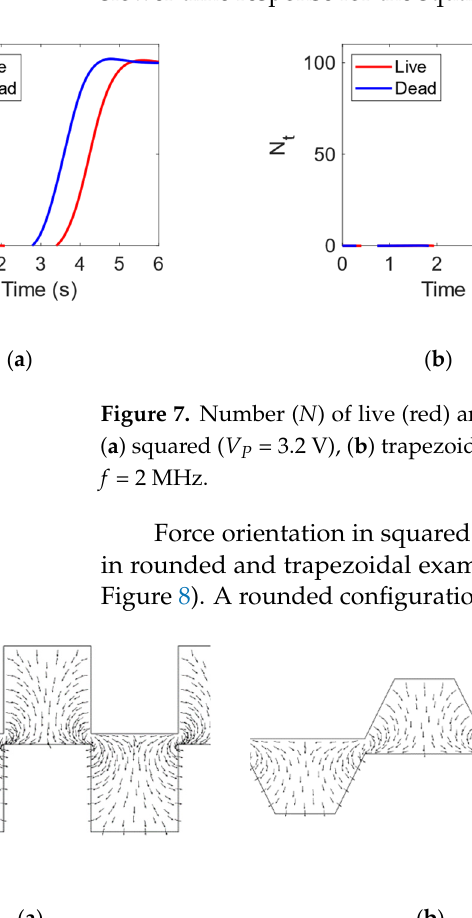
Figure 8. Distribution of the force fi eld in the case of ( a ) squared, ( b ) trapezoidal and ( c ) rounded electrodes.